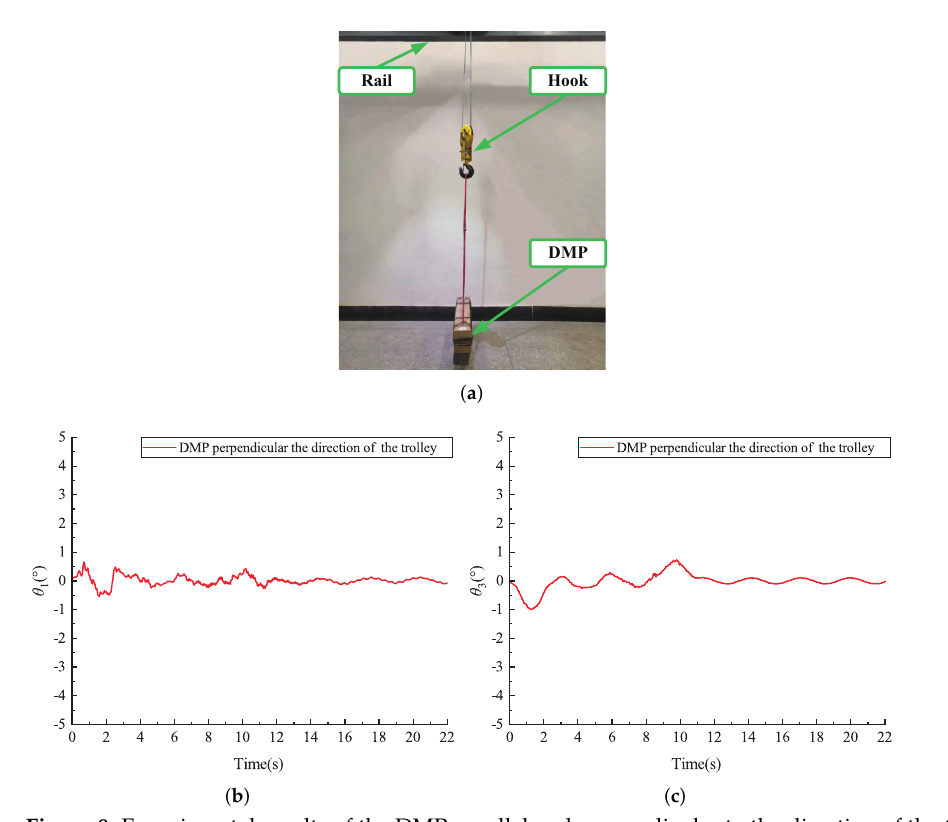
Figure 8. Experimental results of the DMP parallel and perpendicular to the direction of the trolley. ( a ) perpendicular direction of the DMP, ( b ) oscillation responses of the hook, ( c ) oscillation responses of the